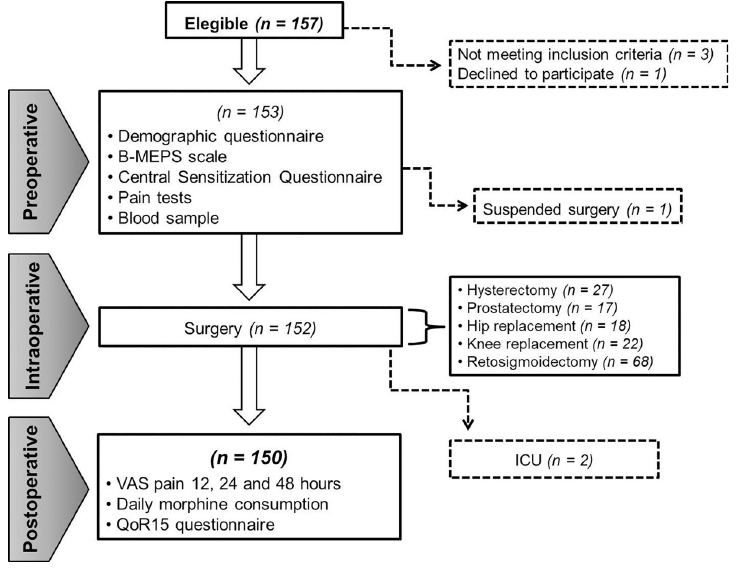
Fig 2. Flow chart of the